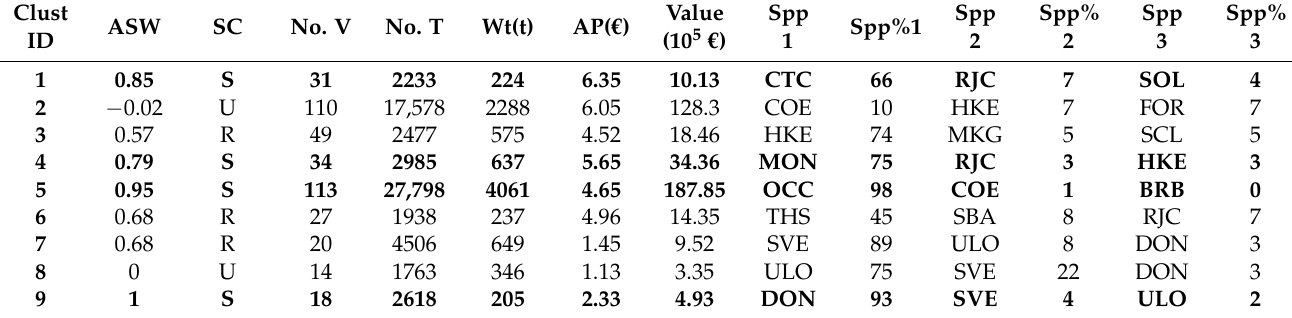
Table 1. Cluster analysis in weight (Annex Figure S1) with the cluster ID, average silhouette width of the cluster (ASW), the silhouette class (SC; S = strong, in bold; R = reasonable; W = weak; U = unstructured), number of vessels (No. V), number of trips (No. T), total weight (in tonnes), average price (AP) in Euros, total value in Euros, the three top species (Spp) and the percentage (Spp%) that each species represented in total landings. (FAO Codes: BRB = Black seabream; COE = Conger eel; CTC = Cuttlefish; DON = Donax clams; FOR = Forkbeard; HKE = Hake; MKG = Thickback sole; MON = Monkfish; OCC = Octopus; RJC = Thornback ray; THS = Bastard soles; SBA = Axillary seabream; SCL = Catshark; SOL = Common sole; SVE = Striped venus clam; ULO = Surf